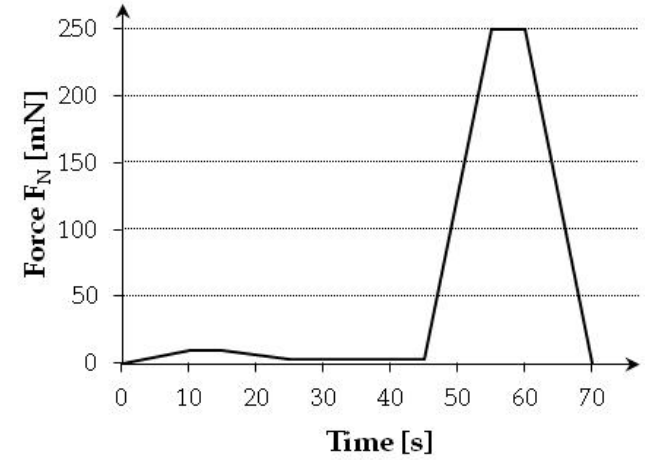
Figure 21. Loading function in each of the tests.